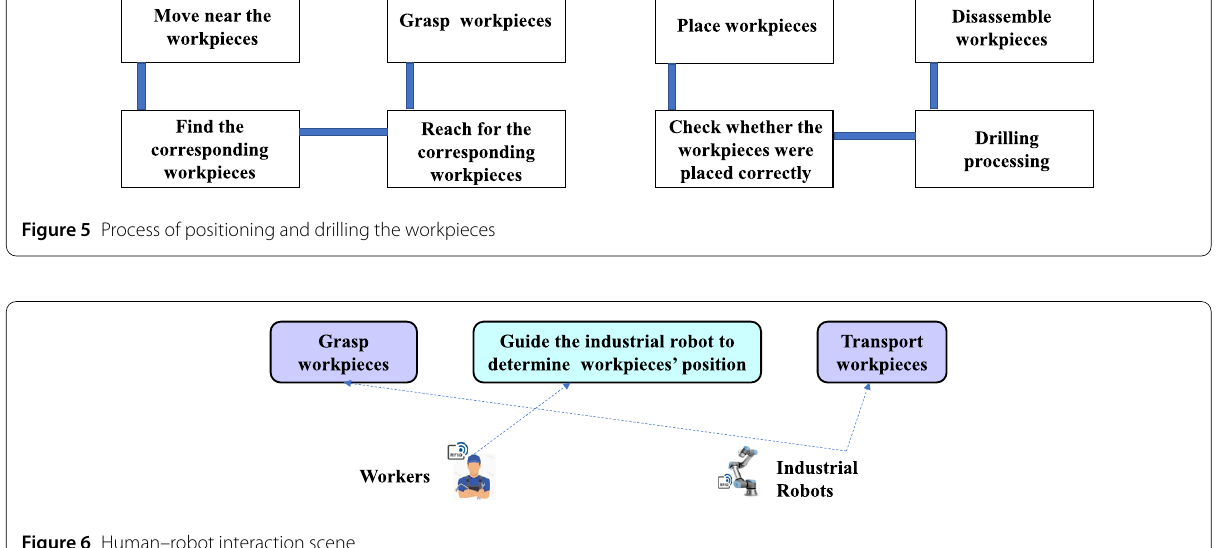
Figure 6 Human–robot interaction